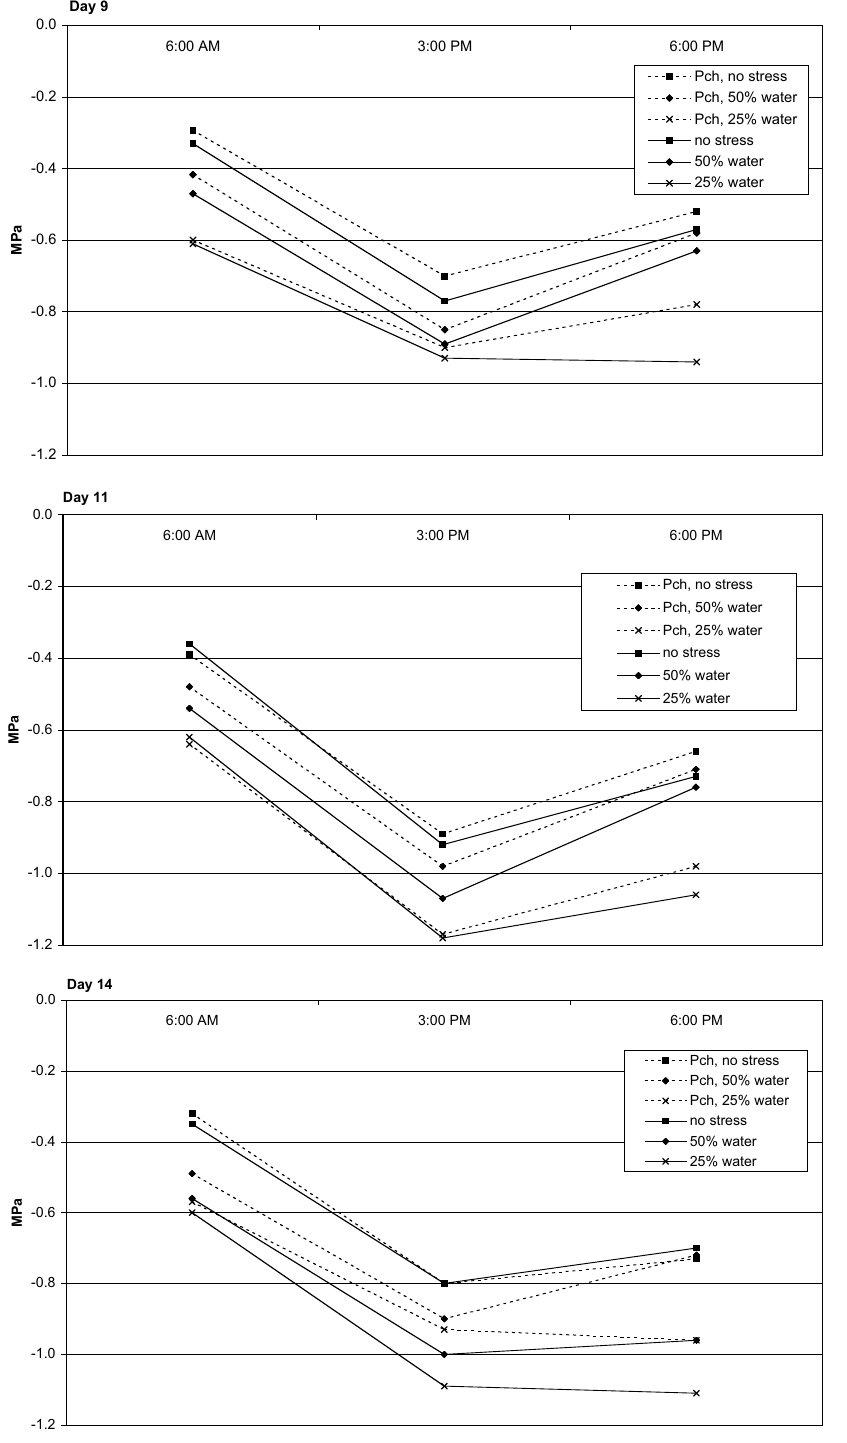
Fig. 8. Effect of 9, 11 and 14 days water stress on leaf water potential of infected and uninfected Chardonnay, March